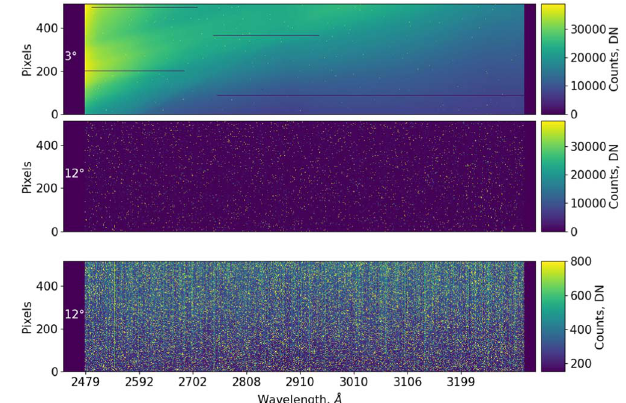
Figure 8. Two 2200 × 515 CUTE frames of different telescope elevation angles, 3 ° and 12 ° , to demonstrate the scattered light feature present at low telescope elevation angles. The elevation of each exposure is marked in the left- side overscan region. The top and middle frames compare the 3 ° and 12 ° elevation angles with the same colorbar. The bottom frame shows the 12 ° frame with a colorbar scaled to the frame. Typical frame features are evident on the 12 ° frame: an increase in counts from the bottom to the top of the frame and hot pixel streaks due to the 32 s CCD readout time. The horizontal dark bars in the top image are missing data packets that were unsuccessfully